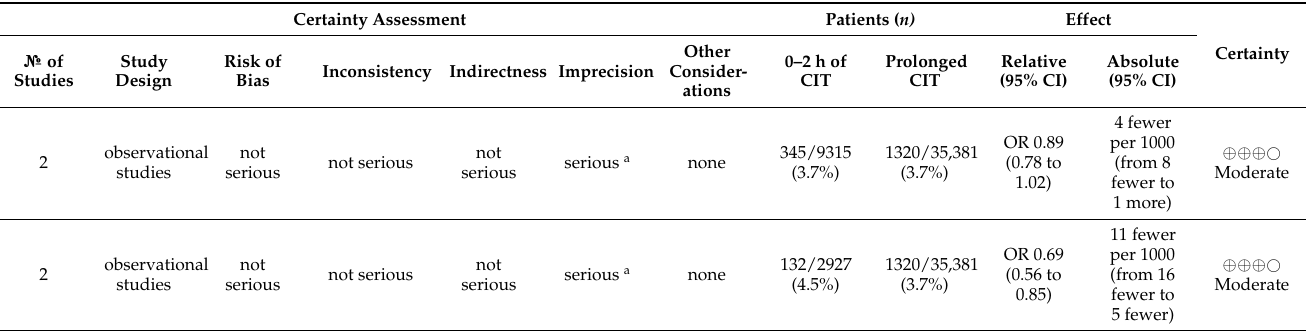
Table A6. Summary of findings with the level of evidence estimated by the Grade-tool for 1-year graft